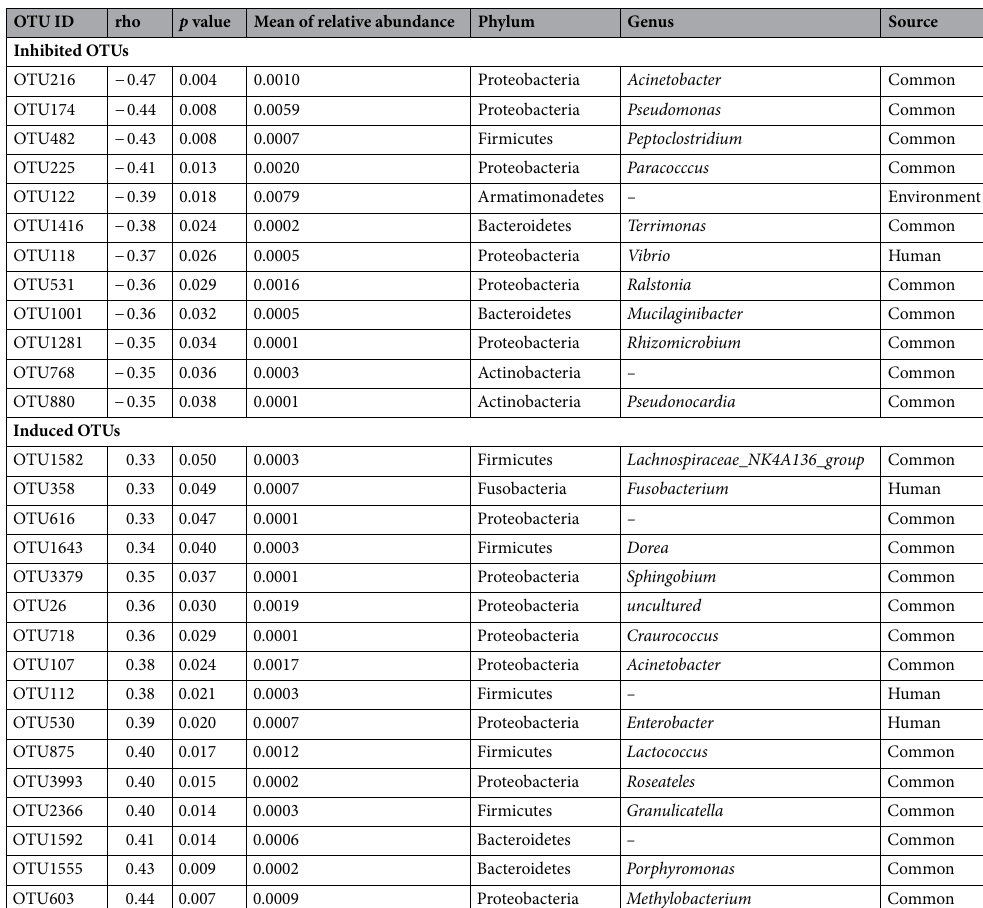
Table 1. Information of gaseous formaldehyde inhibited and induced OTUs. Spearman analysis was carried